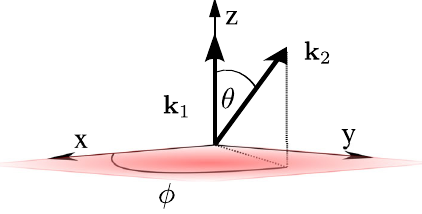
FIG. 6. Schematic illustration of the light-scattering setup. The atoms are confined in the optical lattice close to the xy plane. The incident light field with the wave vector k 1 propagates perpendicular to the lattice in the positive z direction. The wave vector of the scattered light is denoted by k 2 , with the scattering direction determined by the coordinates θ and ϕ